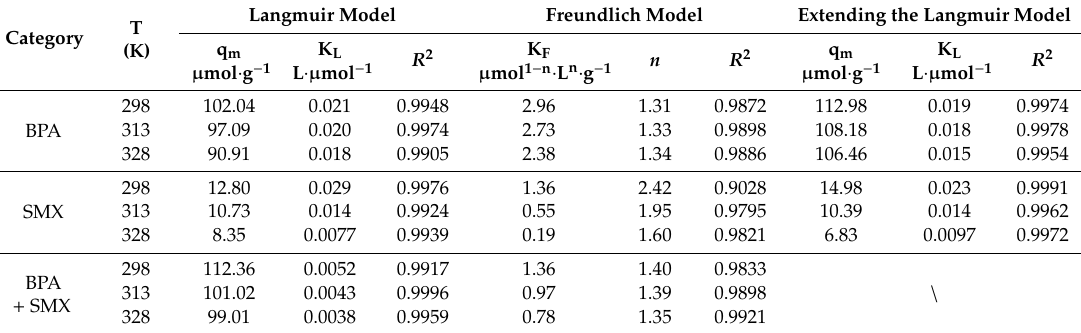
Table 4. Thermodynamic model fitting parameters of binary mixed solution. BPA—bisphenol A; SMX—sulfamethoxazole.